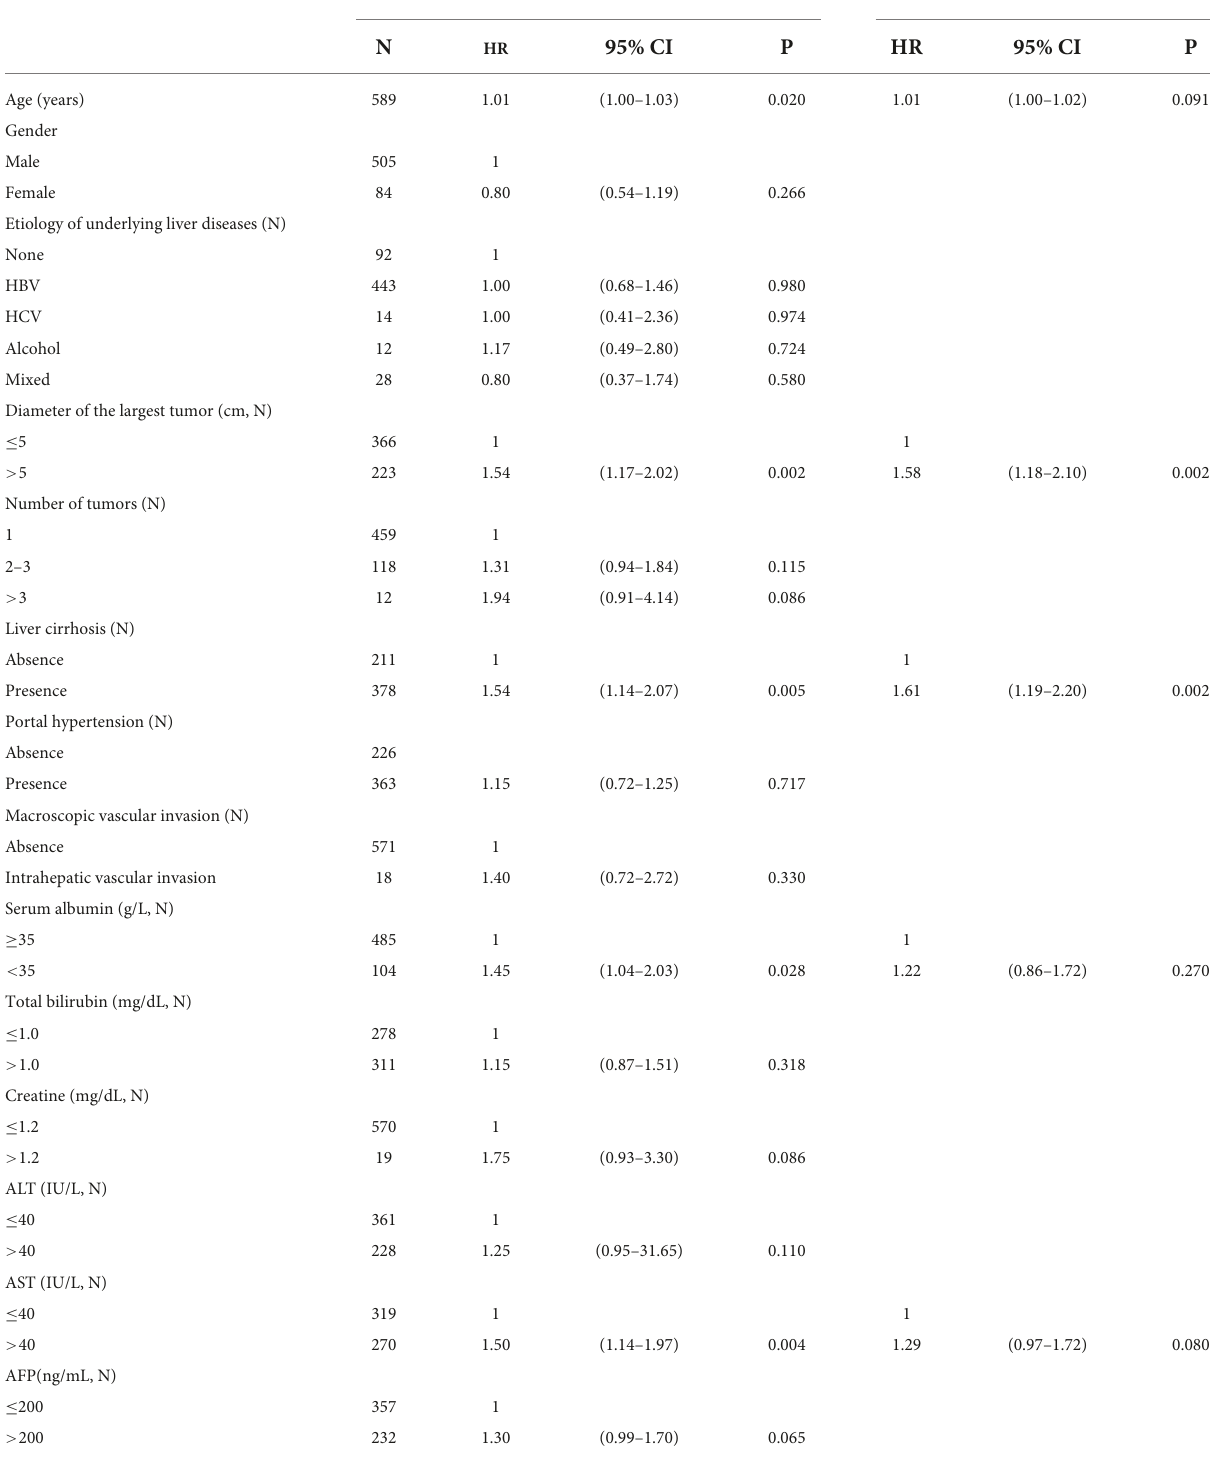
TABLE 4 Univariate and multivariate Cox regression analysis with risk factors of poor prognosis of IPLRs in the HKLC staging system but beyond the BCLC staging system (n = 589). Univariate